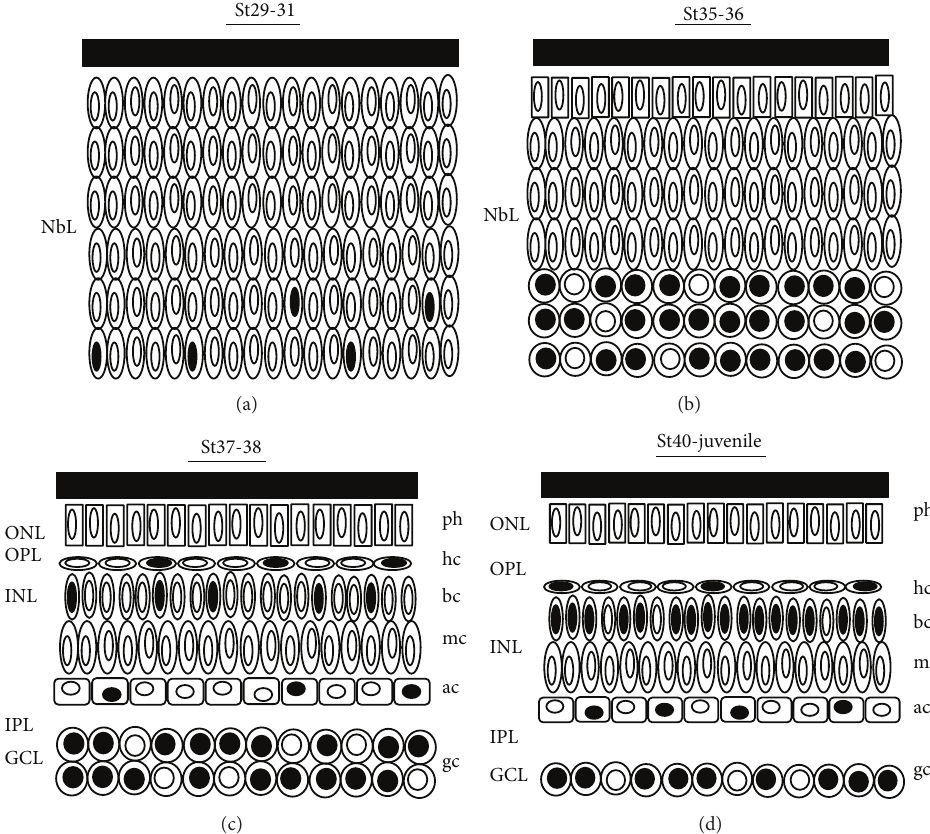
Figure 7: Schematic drawings of the Isl1 positive cells in the developing retina of Xenopus laevis . Black nuclei represent Isl1-immunostained cells. (a) Isl1 immunoreactivity during St29–31 was restricted to nuclei located near the vitreal surface of the NbL. (b) Although the retinal lamination was absent in the St35-36, cell differentiation was detected immunohistochemically. Abundant Isl1-positive cells were located in the vitreal half of the NbL. (c) At St37-38, retinal layering was completed in the central retina with the emergence of the plexiform layers. Isl1 immunoreactivity was detected in the GCL and in cell subpopulations located in the INL. (d) From St40 onwards Isl1 immunoreactivity was confined to subpopulations of ganglion, amacrine, bipolar, and horizontal cells. Ac: amacrine cell; bc: bipolar cell; gc: ganglion cell; GCL: ganglion cell layer; hc: horizontal cell; INL: inner nuclear layer; IPL: inner plexiform layer; L: lens; mc: M¨uller cell; NbL: neuroblastic layer; ONL: outer nuclear layer; OPL: outer plexiform layer; ph: